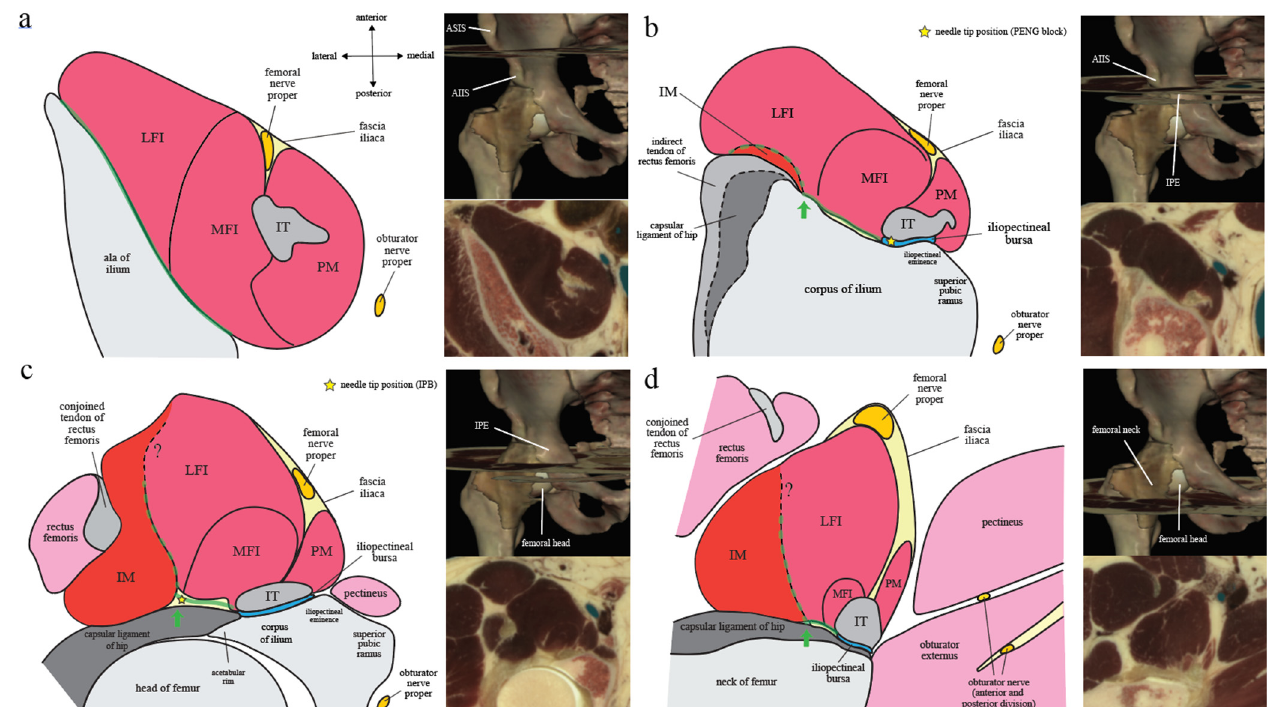
Figure 1. The iliopsoas complex and its surrounding structures of a human right hip were illustrated in transverse sections according to the real cadaveric images (right lower panels) at four successive levels (right upper panels) in craniocaudal order: ( a ) At the level between anterior superior iliac spine (ASIS) and anterior inferior iliac spine (AIIS): The posterolateral wall of iliopsoas plane (IP) is composed entirely of an osseous surface, which is the iliac ala (green solid stroke); ( b ) At the level of iliopectineal eminence, i.e., the pericapsular nerve group (PENG) block level: Note that as IM emerges, IP starts to divide into a muscular part (green dashed stroke), which is the raphe between IM and lateral fibers of iliacus (LFI), and an osseous part (green solid stroke), which is the iliac corpus; ( c ) At the level where femoral head dives deep into the acetabular rim, i.e., the iliopsoas plane block (IPB) level: As the capsular ligaments of hip extend inferolaterally from the acetabular rim, the ligamentous IP, which is a potential space between capsular ligament of hip and the iliopsoas complex, gradually replaces the osseous IP as its posterior wall (green solid stroke). And as the IM muscle substance becomes bigger at this level, rendering the muscular IP (green dashed stroke) more vertical, IP becomes L-shaped; ( d ) At the level where femoral head transits into femoral neck: IP remains L-shaped but the ligamentous IP becomes smaller in area as IM stretches inferomedially, closing up the gap between itself and IT, and inserts into femur just distal to lesser trochanter. At this level, the two divisions of obturator nerve have just left the obturator canal, with the anterior branch traveling inside subpectineal plane (SP) and the posterior branch passing through the obturator externus muscle, on its way to the SP. The most superficial part of the raphe between iliopsoas complex and IM could not be readily distinguished on the cadaveric images and are therefore drawn as a dashed line indicated with question mark. The green arrows indicate the junction between the osseous or ligamentous IP and the muscular IP, and the yellow stars mark the respective final needle tip position of PENG block ( b ) and IPB ( c ). Cadaveric images were reconstructed from real cadavers by the Visible Human Project®of National Library of Medicine and excerpted from the VH Dissector with permission from Touch of Life Technologies Inc